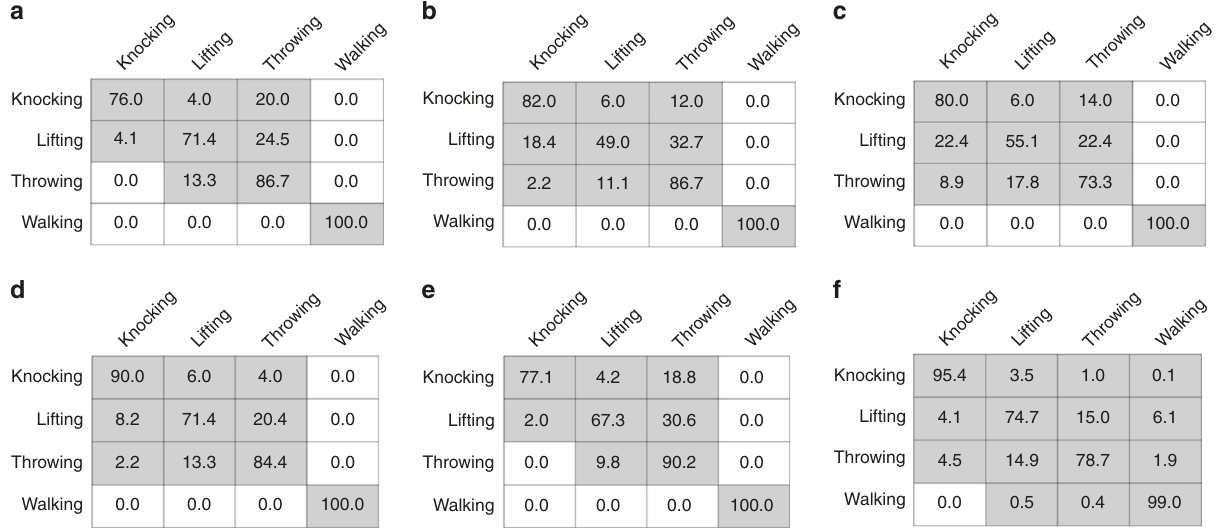
Fig. 4 Confusion matrix for the validation set corresponding to the Biological Motion Library (BML). The results correspond to a support vector machines (SVM), b K-nearest neighbors (KNN), c decision trees (DT), d random forests (RF), e logistic regression (LR), and f deep long short-term memory (LSTM) recurrent neural network (RNN) classi fi ers. The rows and columns represent the percentage of true activity labels and the predicted activity labels,